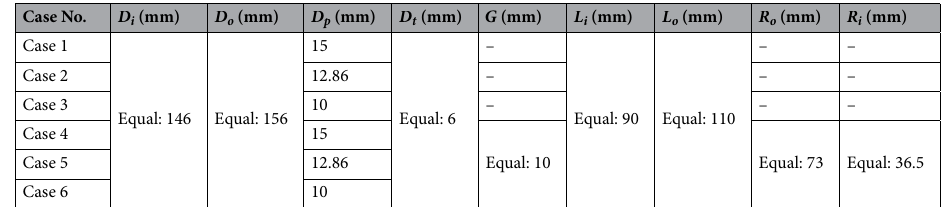
Table 1. Geometrical characteristics of MH reactors for the helical tube (case 1 to case 3) and the semi- cylindrical tube (case 4 to case 6).